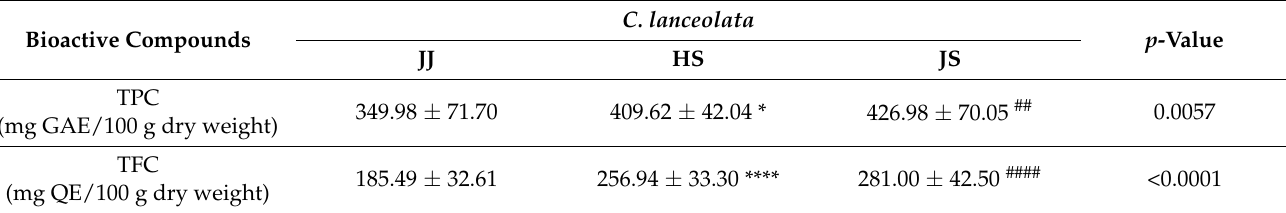
Table 2. Bioactive components of the ethanolic extract in C. lanceolata .